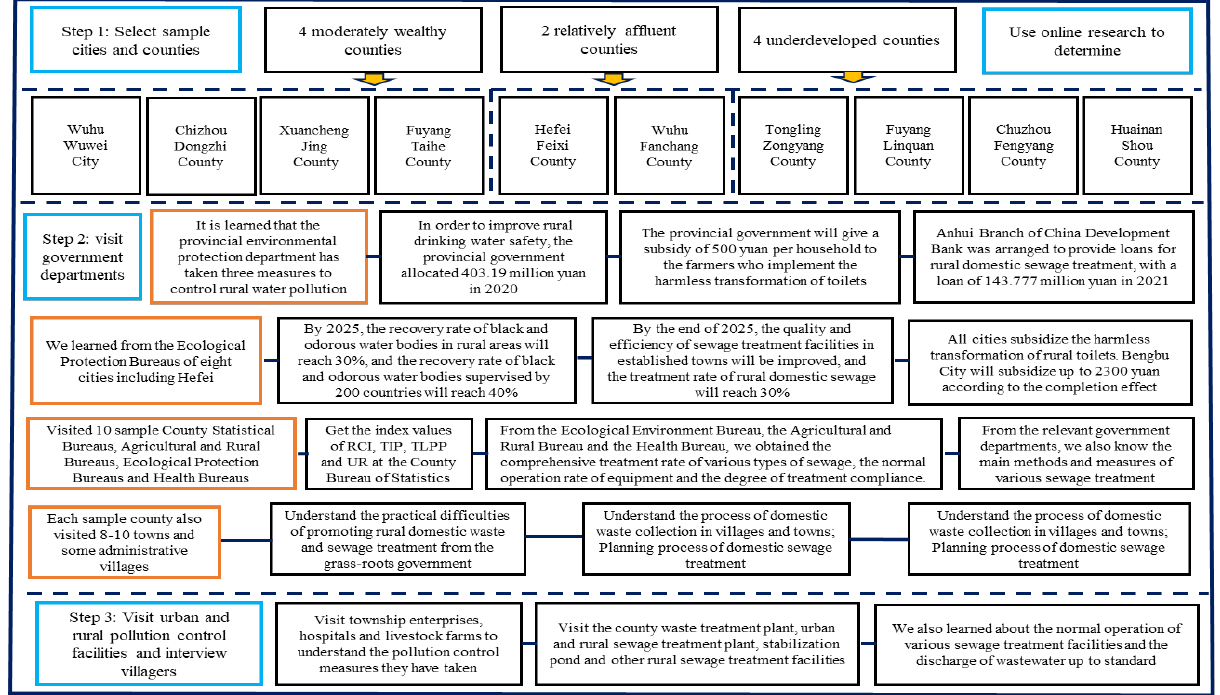
Figure 2. Research process of 10 sample counties (cities) in Anhui.